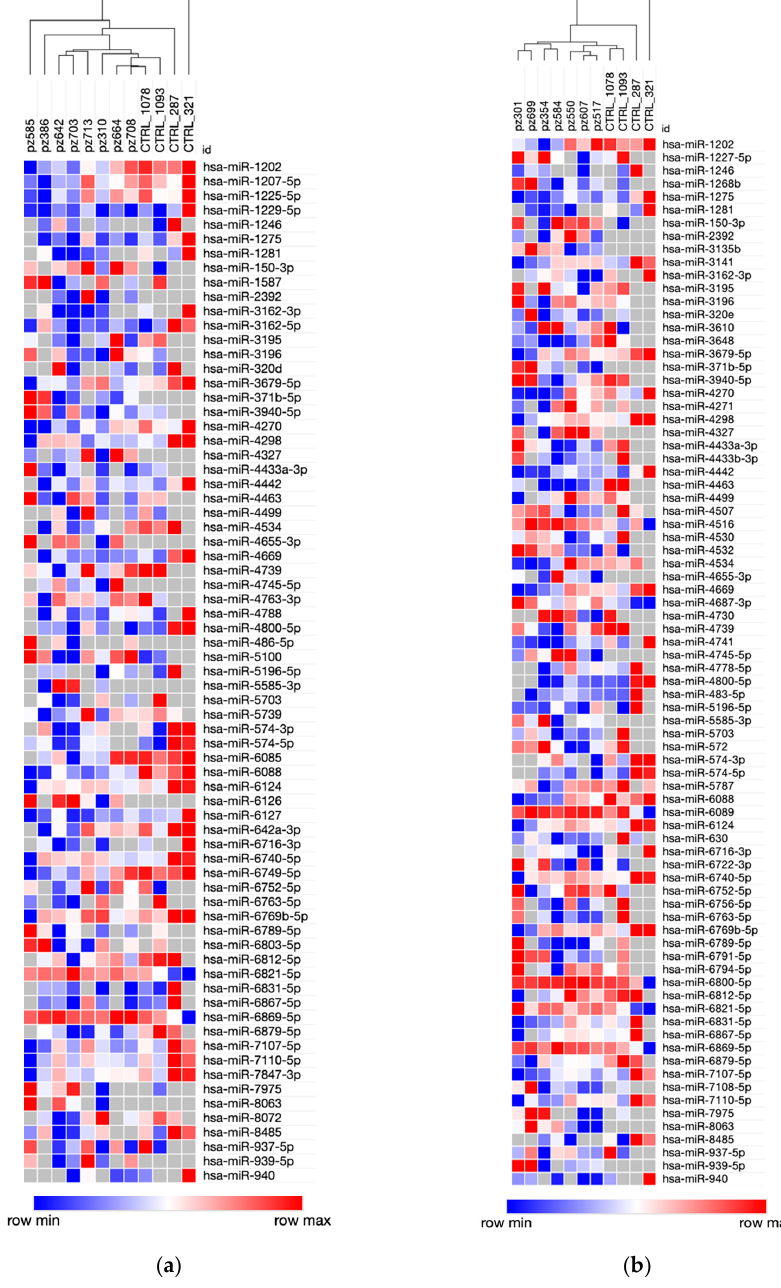
Figure 1. Cluster analysis of differentially expressed miRNAs between PDAC patients and controls. Heat maps representing differentially expressed miRNAs of two different comparisons: long survival patients ( a ) and short survival ( b ) patients with respect to controls. Both dendrograms show the capability of circulating miRNA signatures to clearly separate PDAC patients with respect to controls. A color-coded scale for the normalized expression values is used: red and blue represent high and low expression levels. A complete list of differentially expressed genes identified by SAM two-class algorithm is provided in the Supplementary Materials (Tables S2 and S3).